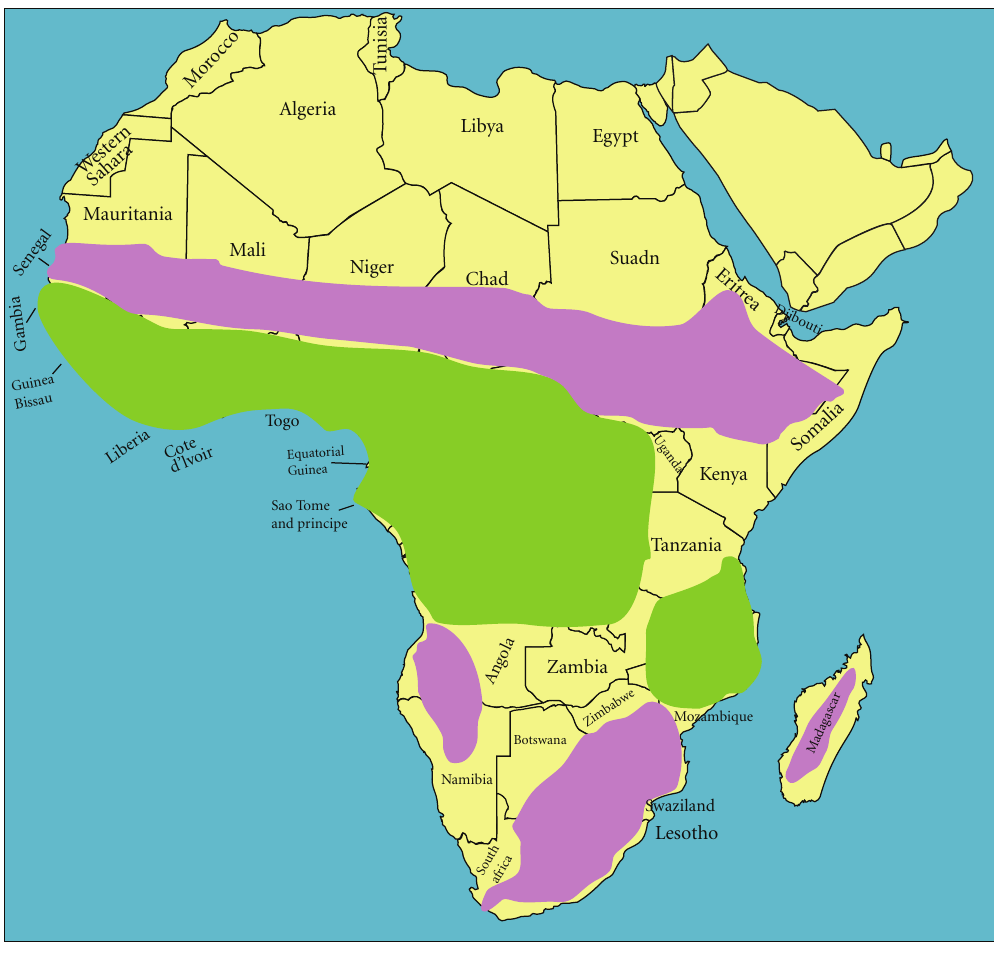
Figure 1: Distribution of tsetse and cattle raising area in Africa http://pathmicro.med.sc.edu/lecture/trypanosomiasis.htm.